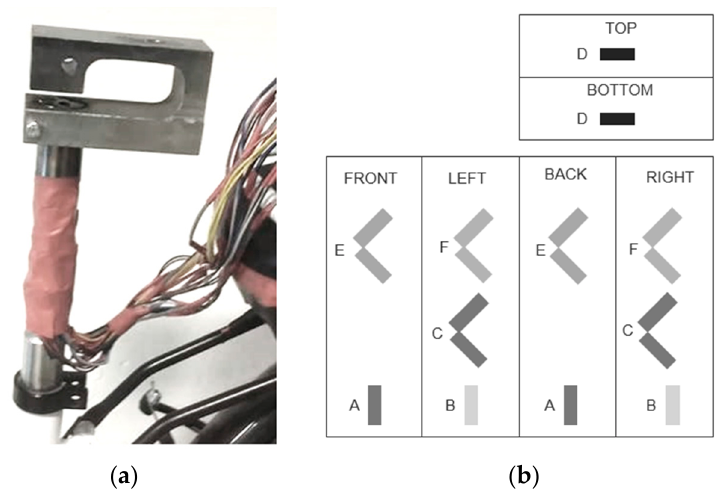
Figure 2. ( a ) the instrumented seat post, ( b ) schema of different views of the seat post to present strain gauge placement for which configuration A: strain gauges to measure sagittal torque; B: strain gauges to measure frontal torque; C: strain gauges to measure transversal torque; D: strain gauges to measure normal force; E: strain gauges to measure anterior force; and F: strain gauges to measure lateral force. The resistance of strain gauges is highly dependent on the longitudinal deformation but also presents a minimal change of resistance due to transverse deformation. Alignment errors of the strain gauge placement makes this phenomenon more pronounced. A calibration matrix is deduced that takes the output signals of all strain gauge configurations into account to cancel out this cross-sensitivity, which is given by (3).